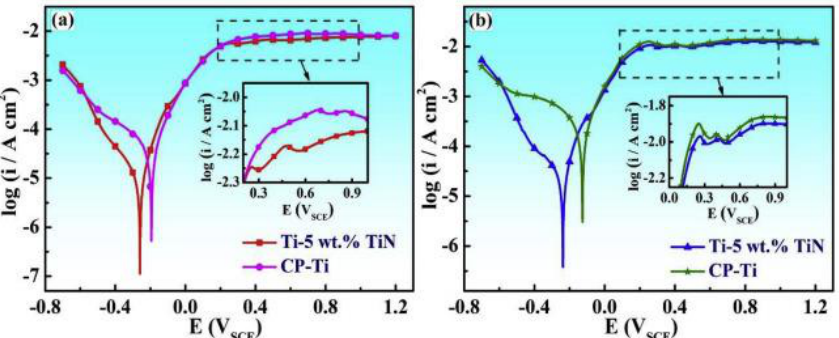
Figure 2. Nitriding treatment enhances the corrosion resistance of titanium. The polarization curves of non-modified pure Ti (CP-Ti) and nitride-treated Ti implants with 5 wt% of TiN composite (Ti-5 wt% TiN) showed that the corrosion potential of nitrided Ti implants was significantly higher than that of CP-Ti post-immersion in 0.5 M HCl solution for ( a ) 0 days and ( b ) 15 days. Reproduced with permissions from